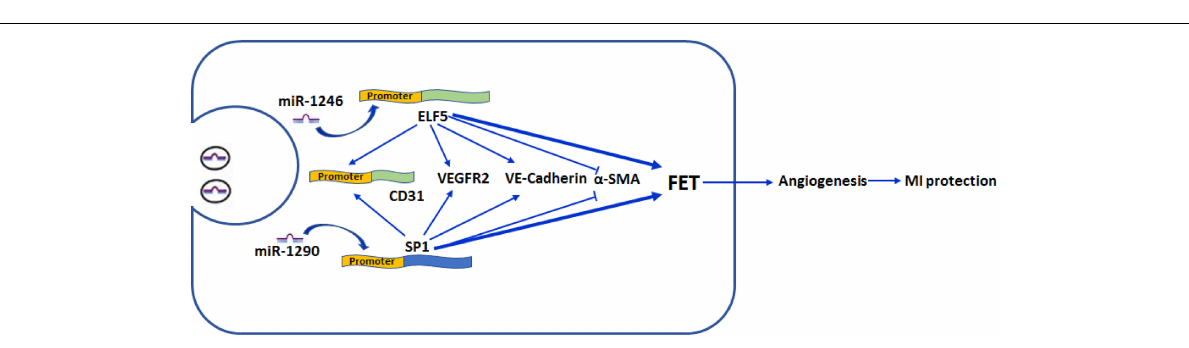
FIGURE 9 | Schematic illustration/of effect by exosomal mir-1246 and -1290 on myocardial infarction. MiR-1246 and -1290 in EPCs could bind to the promoter of ELF5 and SP1 in HCFs, respectively, and induce their expressions. Resultantly, increased ELF5 and SP1 promoted fibroblast-endothelial transition, demonstrated by increased expressions of endothelial markers, CD31 (by binding to the promoter), VEGFR2, and VE-Cad, and decreased expression of a fibroblast marker, α -SMA. Furthermore, they increased angiogenesis. In rats, both exosomal miR-1246 and -1290 contribute to the exosome-attenuated myocardial infarction (MI). All these indicated that both miR-1246 and -1290 in exosomes from EPCs protected the heart against MI, and this was potentially through increased expressions of ELF5 and